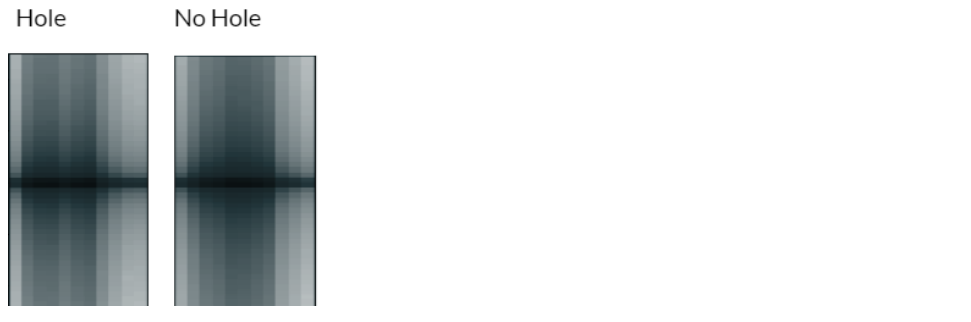
Figure 10. An example of a 200x15x1 STFT for a case with a Hole (left) and a case without a Hole (right). Images have been expanded so that the 15 columns of the image are more visible.